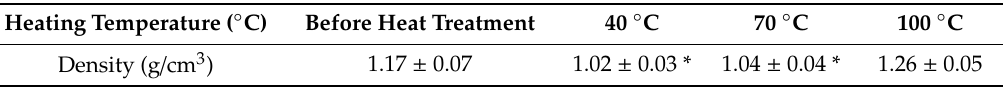
Table 6. Density (g / cm 3 ) of CAG beads.